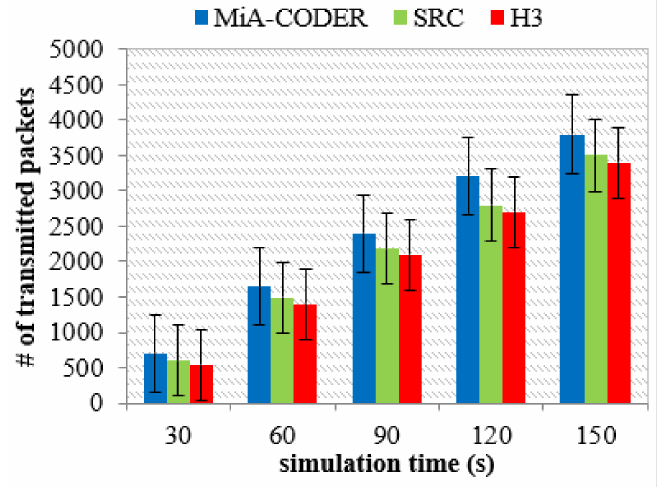
Figure 10. Number of transmitted packets (before coverage hole repair) vs. simulation time.